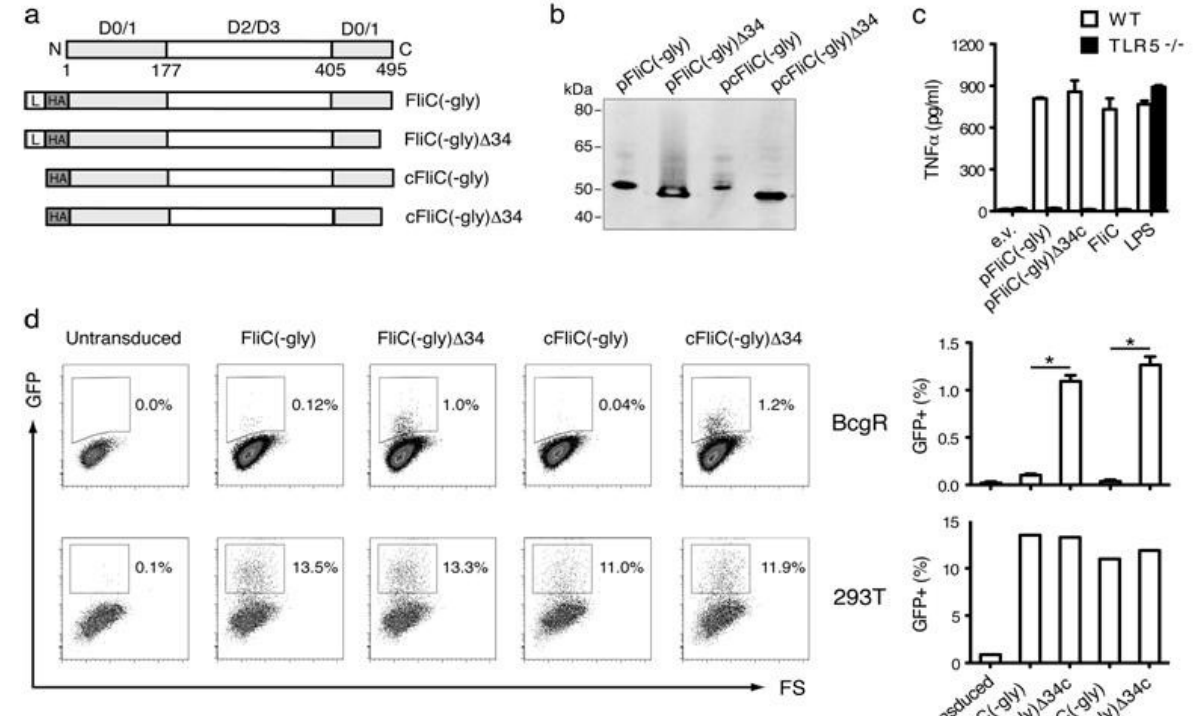
Figure 1. Flagellin (FliC)(-gly) variants for in vivo and in vitro use activate innate immune responses. ( a ) Depiction of pFliC(-gly) and variants relative to FliC polypeptide and domains produced by S. typhimurium . Grey domains D0/1 indicate conserved regions important for activating innate immune responses. L and HA indicates a leader and HA-epitope tag domains respectively. Names of the four FliC(-gly) constructs used in this study are indicated to the right of the drawings; ( b ) Western blot analysis of cellular lysates from 293T cells transfected with the indicated constructs. Apparent molecular weights were determined by comparison to the standard depicted to the left of the blot. Signals were not detected from cells transfected with empty vector (data not shown); ( c ) Release of TNF  from B6 alveolar macrophages but not Toll-like Receptor 5 (TLR5) −/− alveolar macrophages after stimulation with FliC(-gly) and FliC(-gly)  34. Supernatant from 293T cells transfected with pFliC(-gly) and pFliC(-gly)  34 vectors was incubated with cells for 4 h followed by analysis of secreted TNF  by ELISA. Data are mean ± SEM of triplicate samples representative of two independent experiments; ( d ) Activation of pyroptotic cell death by retroviral transduction of BcgR macrophages with constructs expressing FliC(-gly) but not FliC(-gly)  34 as determined by GFP expression. Upper panels represent representative data from BcgR cells transduced with FliC(-gly), FliC(-gly)  34 and controls (as indicated) when comparing GFP and forward-scatter (FS) parameters. Quantitative data of the percentage of GFP positive BcgR cells from each construct after transduction. Lower panel represent representative data from 293T cells transduced in identical fashion. Data are mean ± SEM of GFP positive cells observed during three independent transduction experiments. * Differences of the response relative to the FliC(-gly) construct without  34 defined as p ≤ 0.05 calculated using a two-tailed unpaired Student t